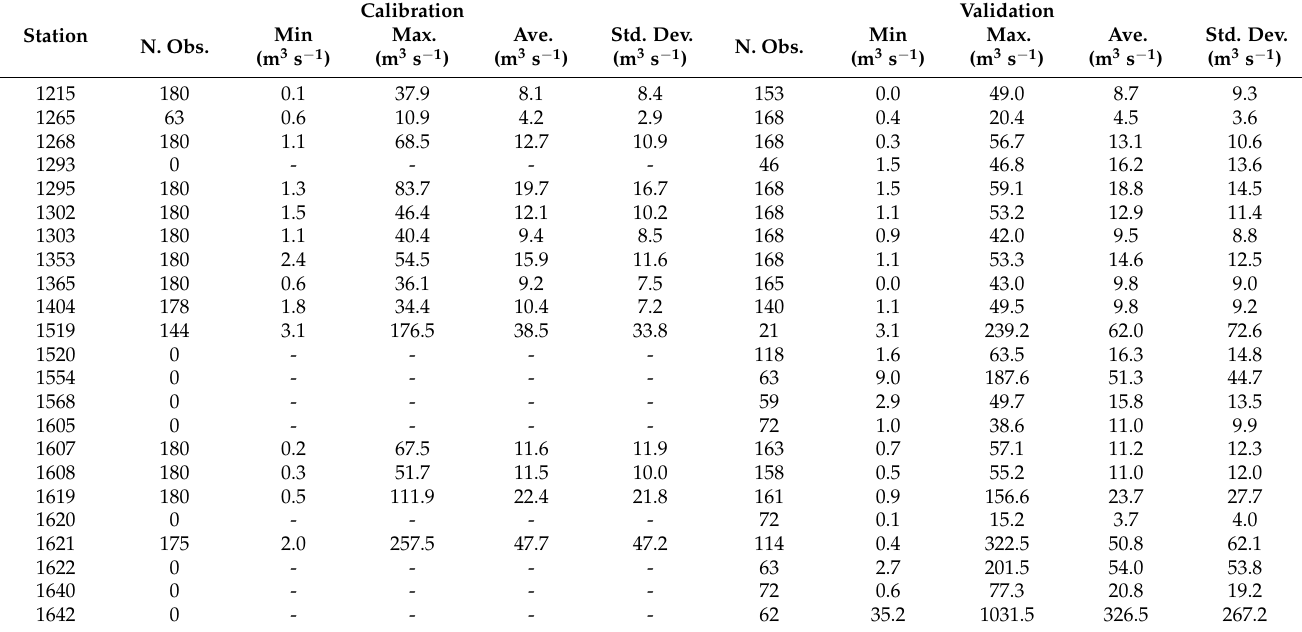
Table A1. Number of observations (N. obs.), minimum (Min), maximum (Max), average (Ave), and standard deviation (Std. Dev.) of flow values in calibration and validation